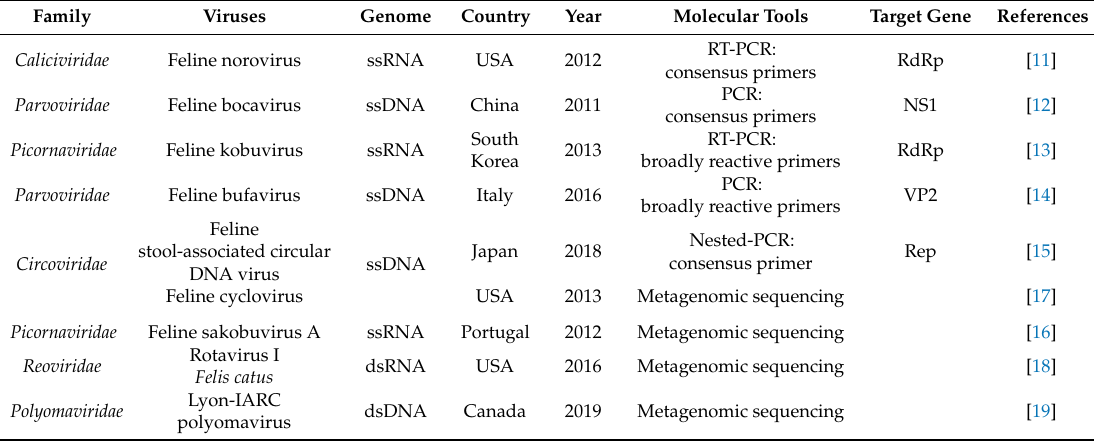
Table 1. Novel viruses detected in the stool samples of cats by the molecular approach since 2012.